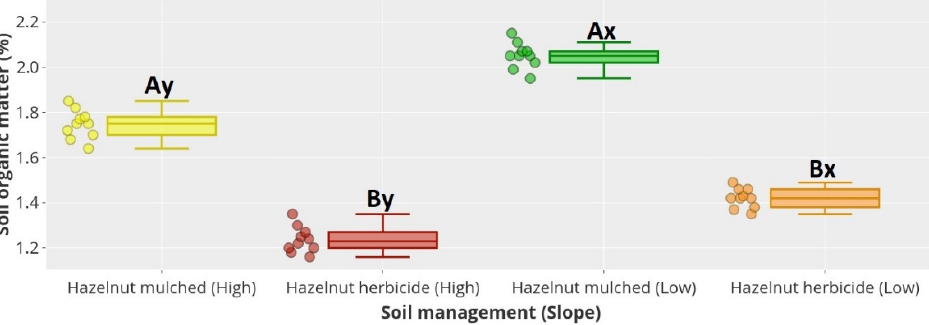
Figure 4. Soil organic matter (SOM) distribution according to the soil management and slopes. Upper hanging bar (high edge), lower hanging bar (low edge), upper box line (third quartile), line (median), and lower box line (first quartile). Different uppercase letters (A, B) represent significant differences between soil managements ( p < 0.05). Different lowercase letters (x, y) represent significant differences between slopes ( p < 0.05).